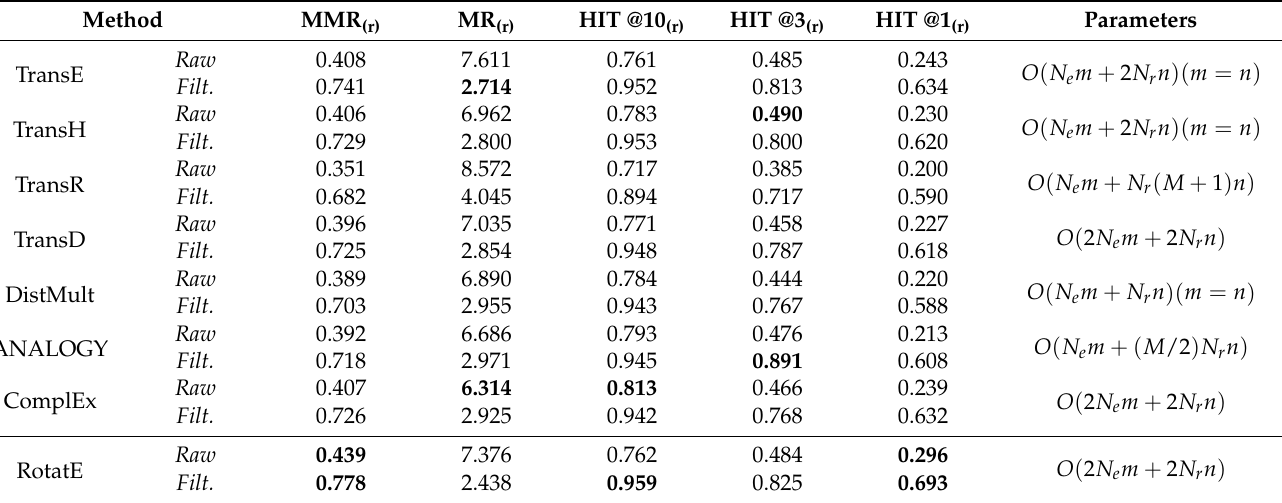
Table 7. The learning results of different representation learning models on our graph ( bold : the best values). In parameters, N e and N r are the numbers of unique entities and relations; m and n are the dimensions of embedding vectors of entities and